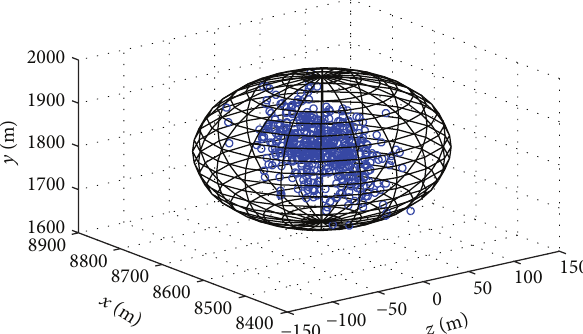
Figure 13: The equiprobable error ellipsoid of the target acquisition points.